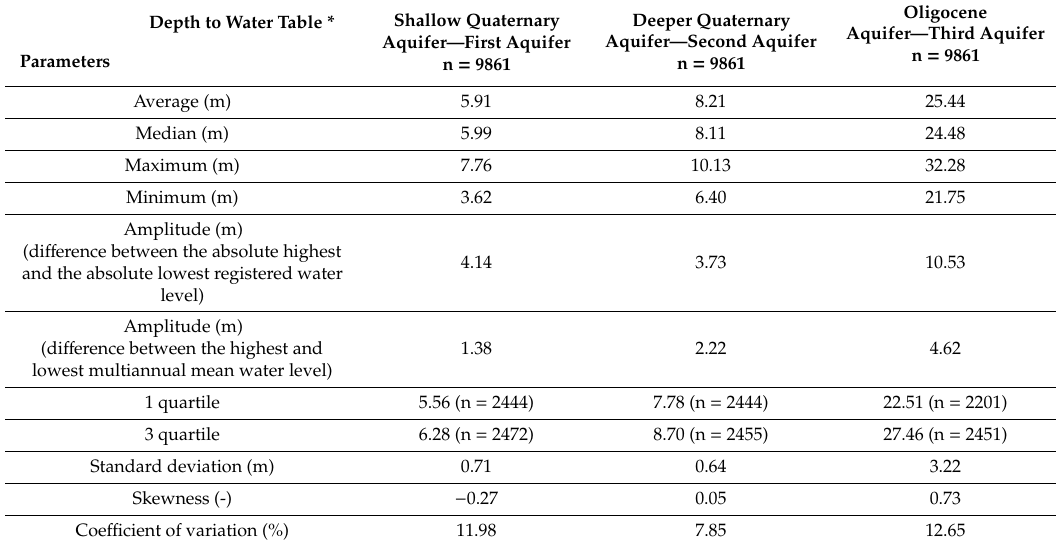
Table 1. Basic statistical parameters of the analyzed